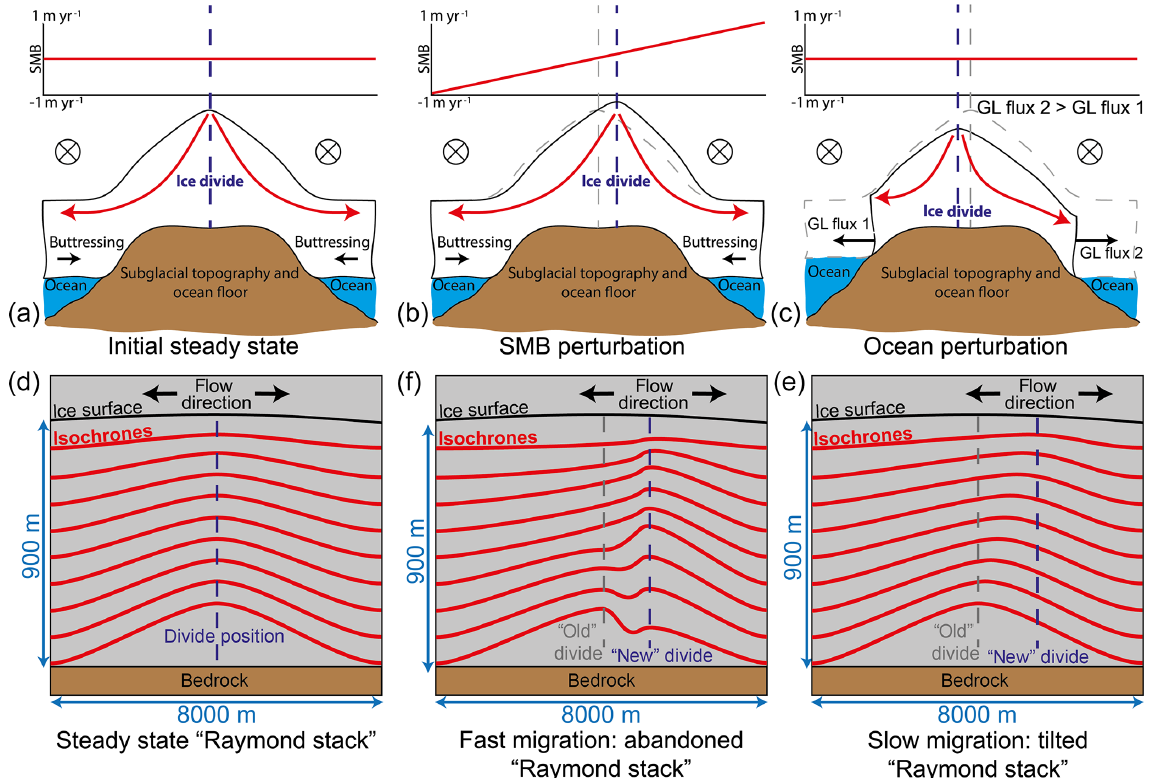
Figure 2. Upper panel ( a – c ) shows schematic (a) steady state, (b) divide migration induced by asymmetric surface mass balance forcing, and (c) divide migration induced by ocean perturbation forcing. Buttressing in (c) is asymmetric. Solid red arrows indicate approximate ice-flow path from the ice-rise divide to ice shelf. Grey dashed lines in (b) and (c) display the steady-state geometry and divide position of (a) . GL is the grounding line. Lower panel ( d – f ) shows schematic of expected internal stratigraphy for steady state (d) , fast migration (e) , and slow migration (f) . (e) and (f) are not necessarily the result of forcing in (b) and (c) ,